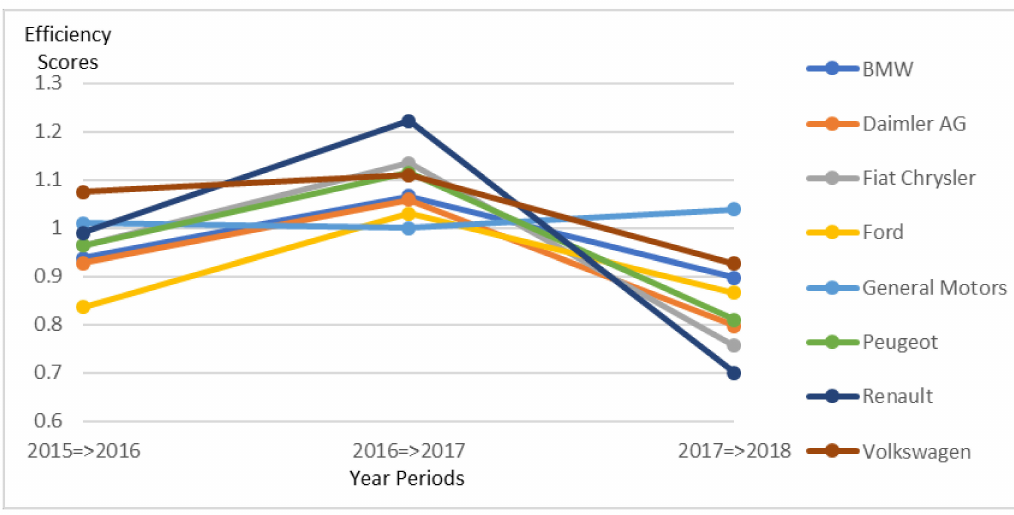
Figure 12. Total-factor-productivity change of European–American